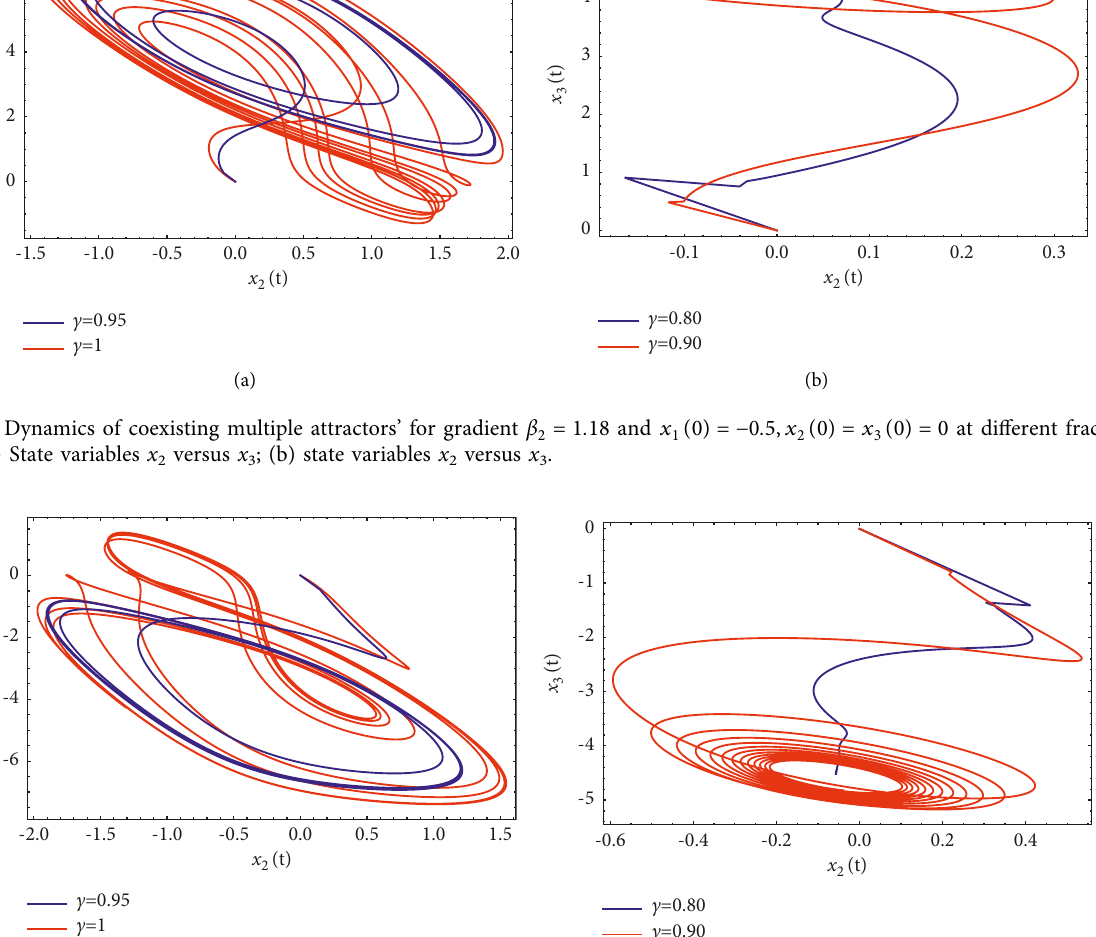
� 1 . 18 and x ( 0 ) � 1 , x ( 0 ) � x ( 0 ) � 0 at different fractional orders. 1 2 3 2